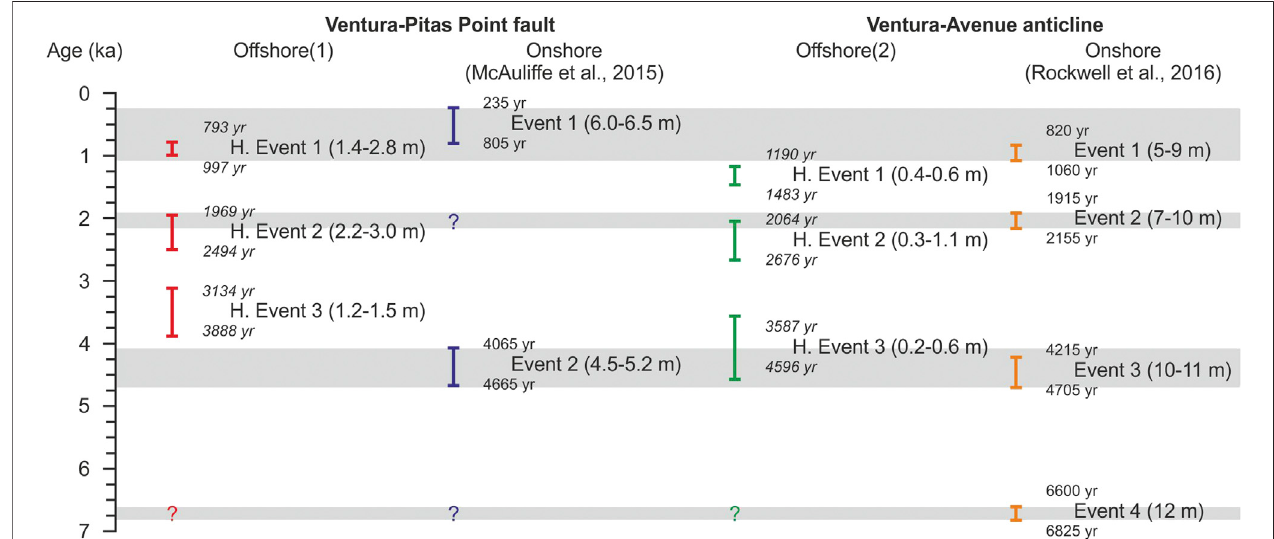
FIGURE15| Comparison oftheages (verticalbars)and the vertical uplifts(numbersbetween brackets)for theonshore paleoseismological events(McAuliffe et al., 2015; Rockwell et al., 2016) and offshore deformation uplift events for Ventura-Pitas Point fault (1; pro fi le D01L03 Figure 9 ) and the Ventura Avenue anticline (2; pro fi le D03L03 Figure11B ).Horizontalgraybandsconsiderthemaximumandminimumagesobtainedontheonshorestudiesforeachevent,consideringthattheseagesare more reliable than the estimated ages based on the offshore seismic pro fi les.